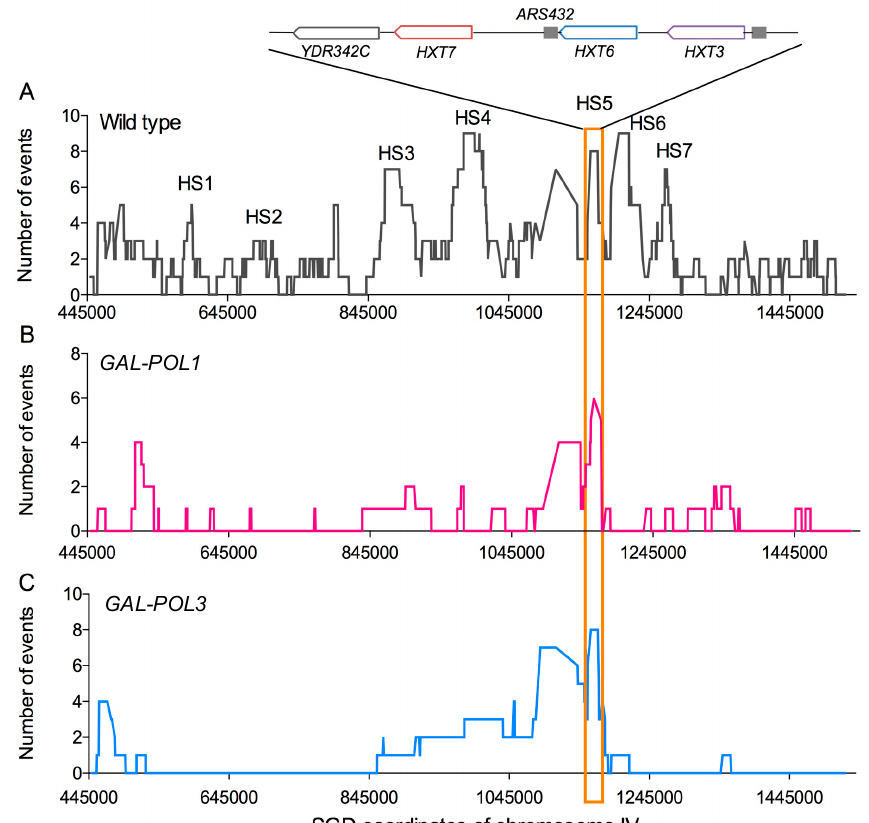
Figure 5. Mitotic recombination hotspots on the right arm of chromosome IV in wild-type, GAL1-POL1 , and GAL1-POL3 strains. Crossover events on the right arm of chromosome IV were selected using the system described in Figure 3, and events were mapped using SNP microarrays. The Y axis of the plots represent the number of times a SNP is included in conversion tracts associated with a crossover; the X axis shows the SGD coordinates from CEN4 to the right telomere. ( A ) Recombination events in the wild-type diploid [23]. Hotspots of recombination activity are labeled HS1–HS7. HS5, which contains three directly oriented HXT genes, has high levels of recombination in all three strains. ( B ) Recombination in cells with low levels of Pol α [12]. ( C ) Recombination in cells with low levels of Pol δ [13].